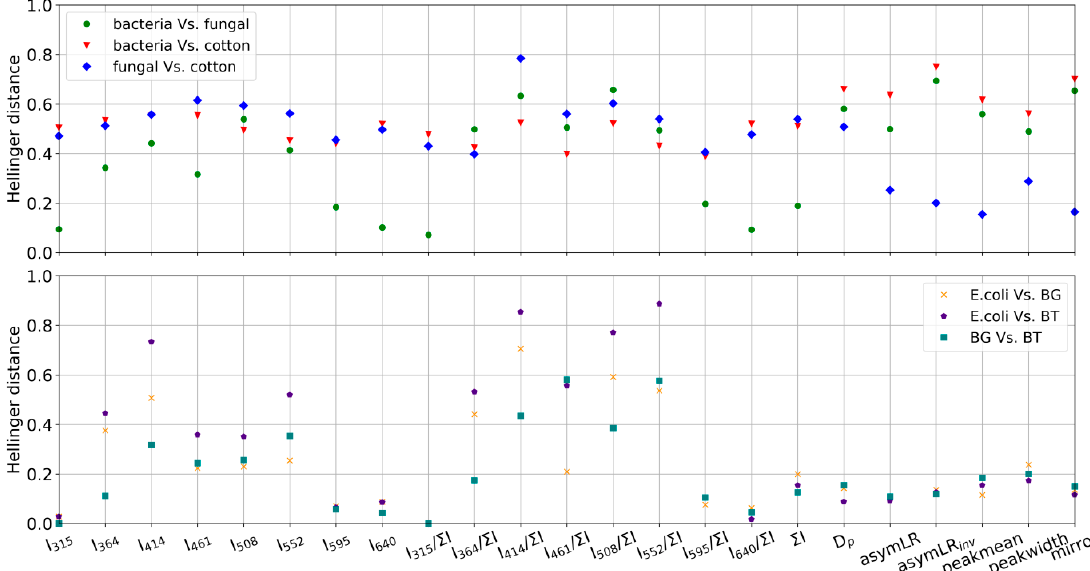
Figure 3. ACS training data Hellinger distances for each parameter. Top panel: inter-class comparison of the broad classes. Bottom panel: intra-class comparison of the three bacterial samples. The Hellinger distance metric quantifies the similarity between two probability distributions where values towards zero indicate similarity between distributions and a value of 1 indicated dissimilarity.